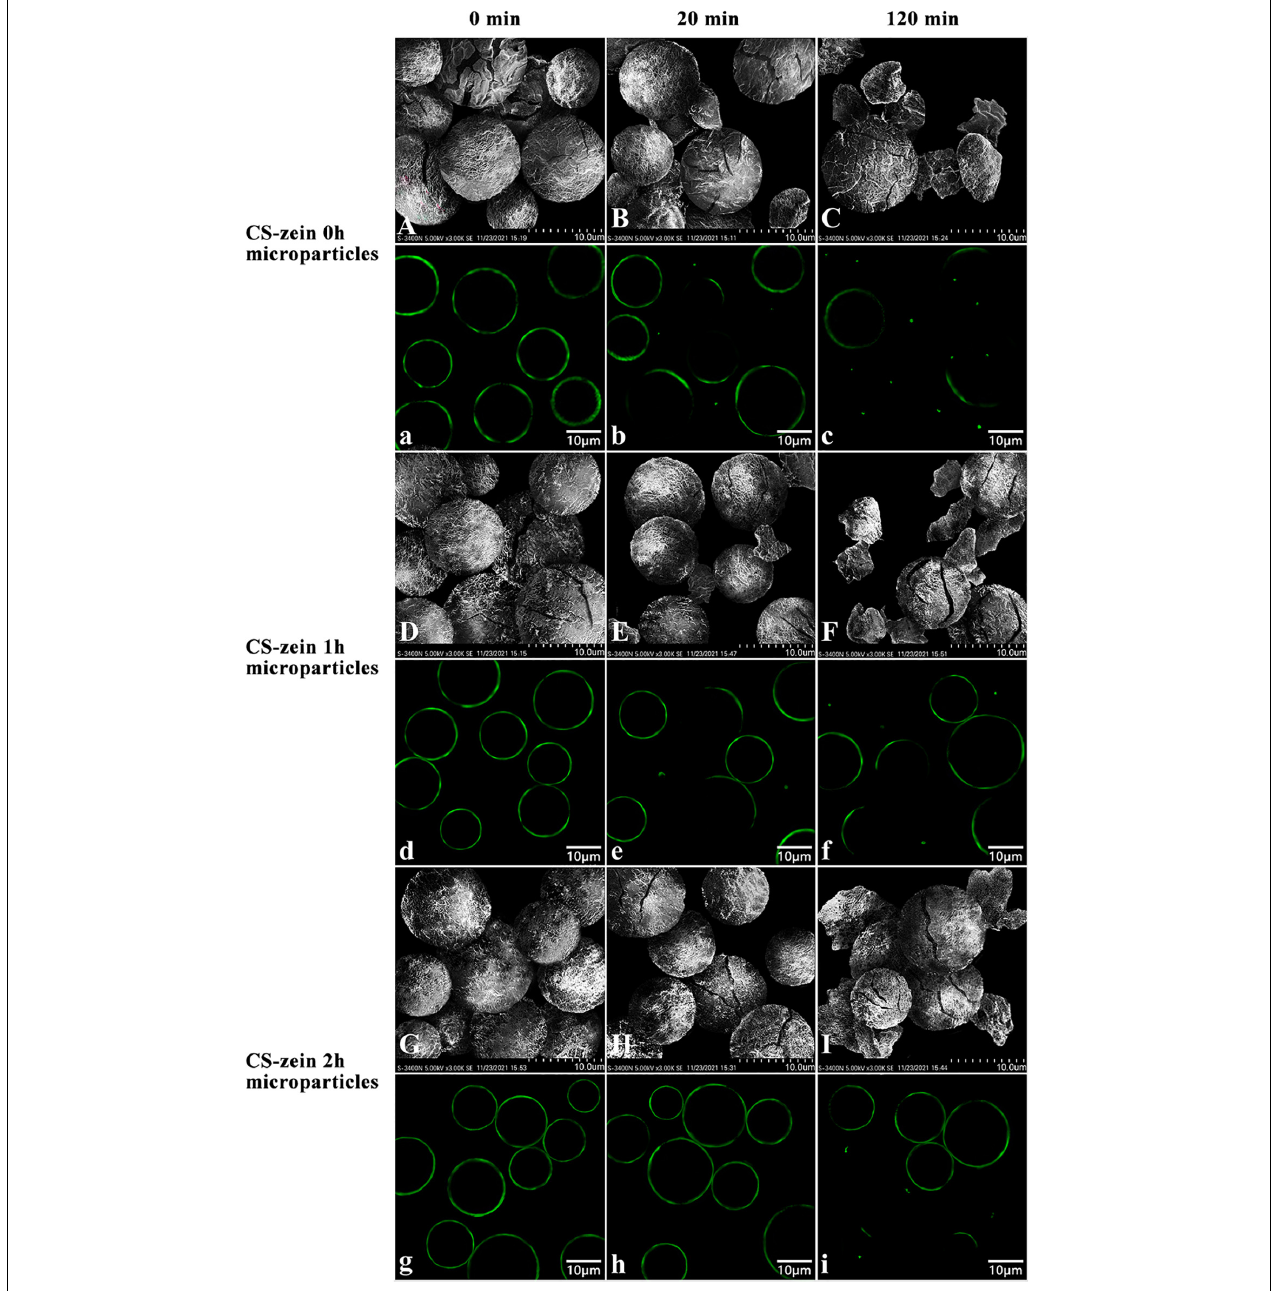
FIGURE 10 | Scanning electron micrographs and confocal scanning laser microscopic images of CS-zein 0h microparticles after 0 min (A, a) , 20 min (B, b) , 120 min (C, c) of enzymatic hydrolysis, and CS-zein 1h microparticles after 0 min (D, d) , 20 min (E, e) , 120 min (F, f) of enzymatic hydrolysis, and CS-zein 2h microparticles after 0 min (G, g) , 20 min (H, h) , 120 min (I, i) of enzymatic